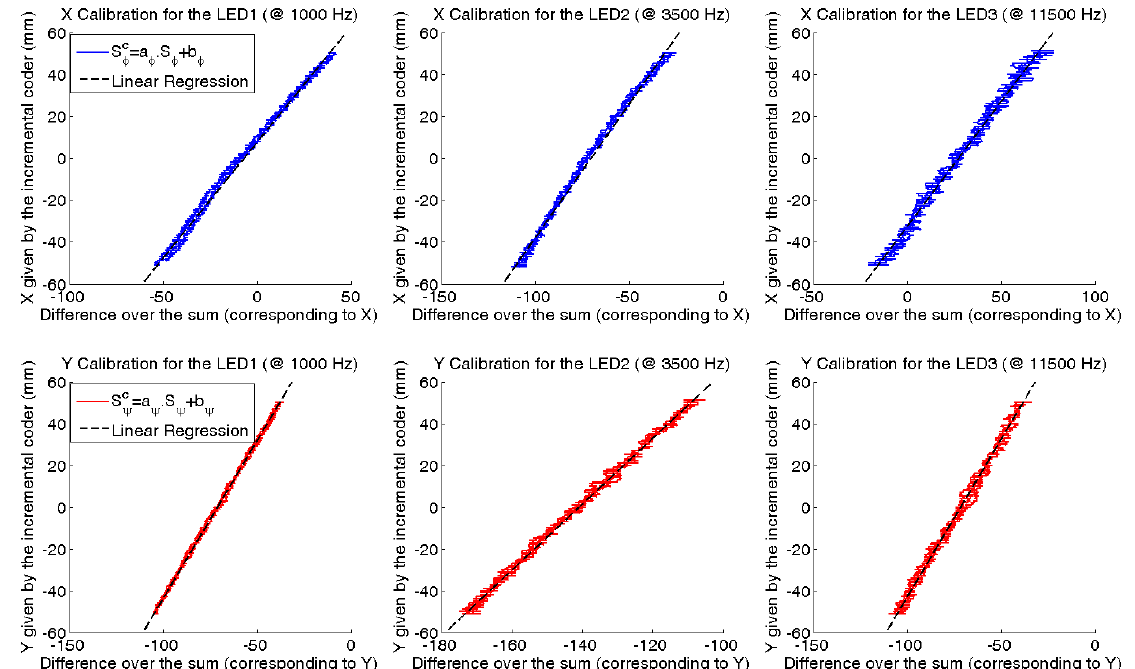
Figure 11. X and Y are measured by an incremental encoder for each direction and LED LED are plotted as a function of S and S . Linear regressions used to determine a ϕ ψ b are also plotted. We note that the curves are linear on the range ψ